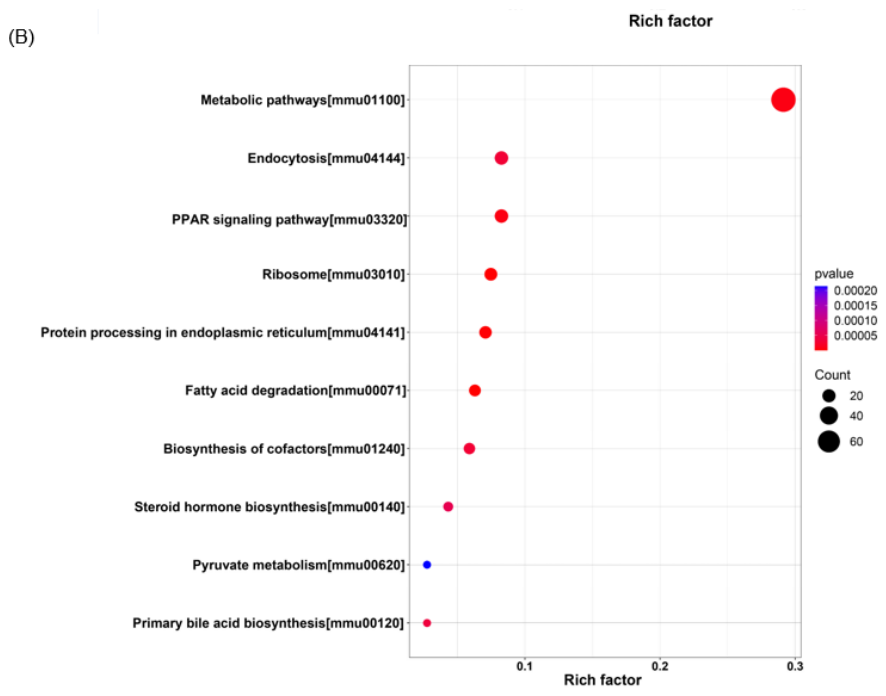
Figure 10. KEGG analysis of the signaling transduction pathways in Control vs. HFD ( A ) and HFD-T vs. HFD ( B ).